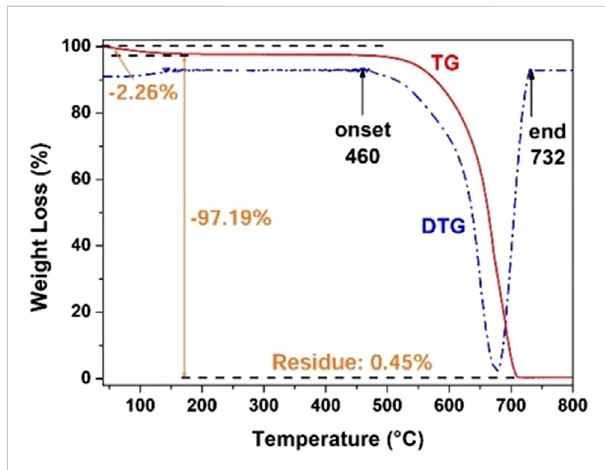
FIGURE 9 TG/DTG curves of the synthesized g-C 3 N 4 catalyst in air. Reproduced with permission from reference (Xiao et al.,